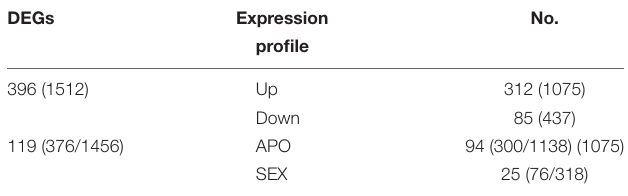
TABLE 3 | Differentially expressed